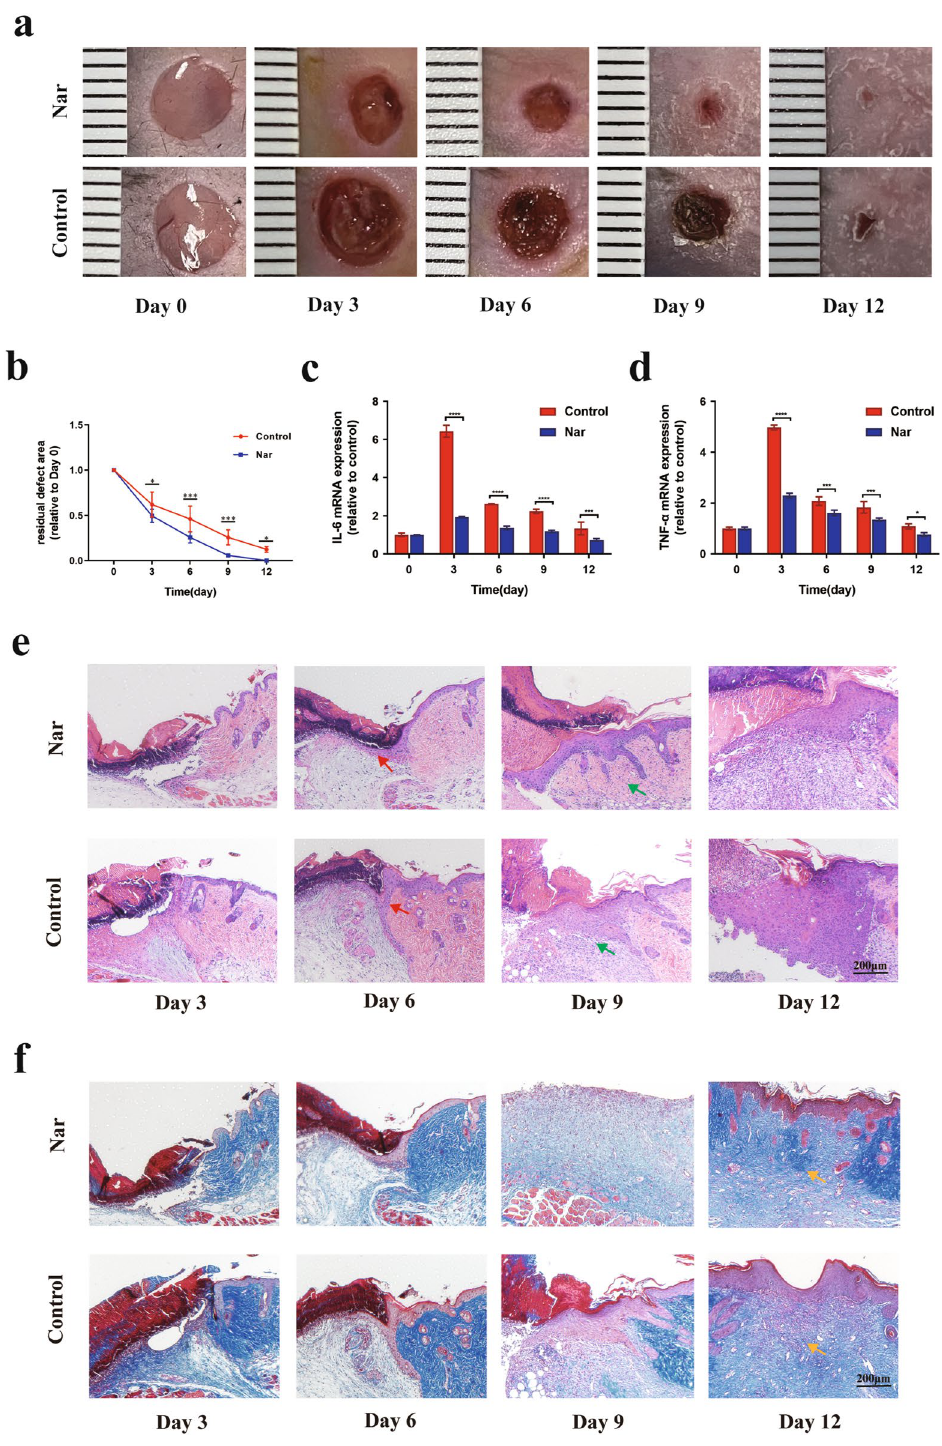
Figure 5. Effects of naringenin on wound healing. ( a ) Representative images of skin wounds in mouse models. Unit: millimetres (mm) ( b ) Residual defect areas. ( c , d ) The mRNA expression of inflammation-related markers in mice. Representative images of H&E ( e ) and Masson’s trichrome staining ( f ) of the sections on days 3, 6, 9 and 12 post-wounding in the naringenin-treatment group and control group, scale bar = 200 µm. Red arrows indicate the formation of new epithelial tissue, green arrows indicate inflammatory cells, and yellow arrows indicate collagen fiber. Data are presented as the means ± SDs of 5–6 mice. Bar chart data were compared by Student’s t test or ANOVA. * P < 0.05, ** P < 0.01, *** P < 0.001, and **** P <